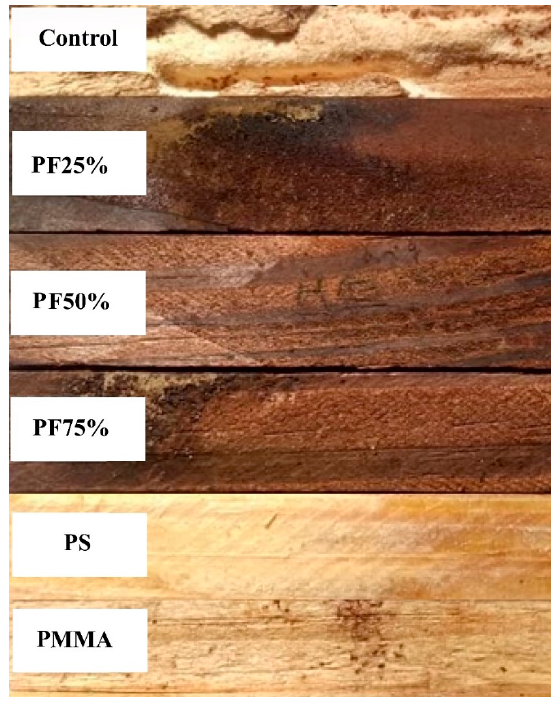
Figure 4. Photos for the control and treated pine woods subjected to termite attack. Where PF25% is 25% of poly (furfuryl alcohol), PF50% is 50% of poly (furfuryl alcohol), PF75% is 75% of poly